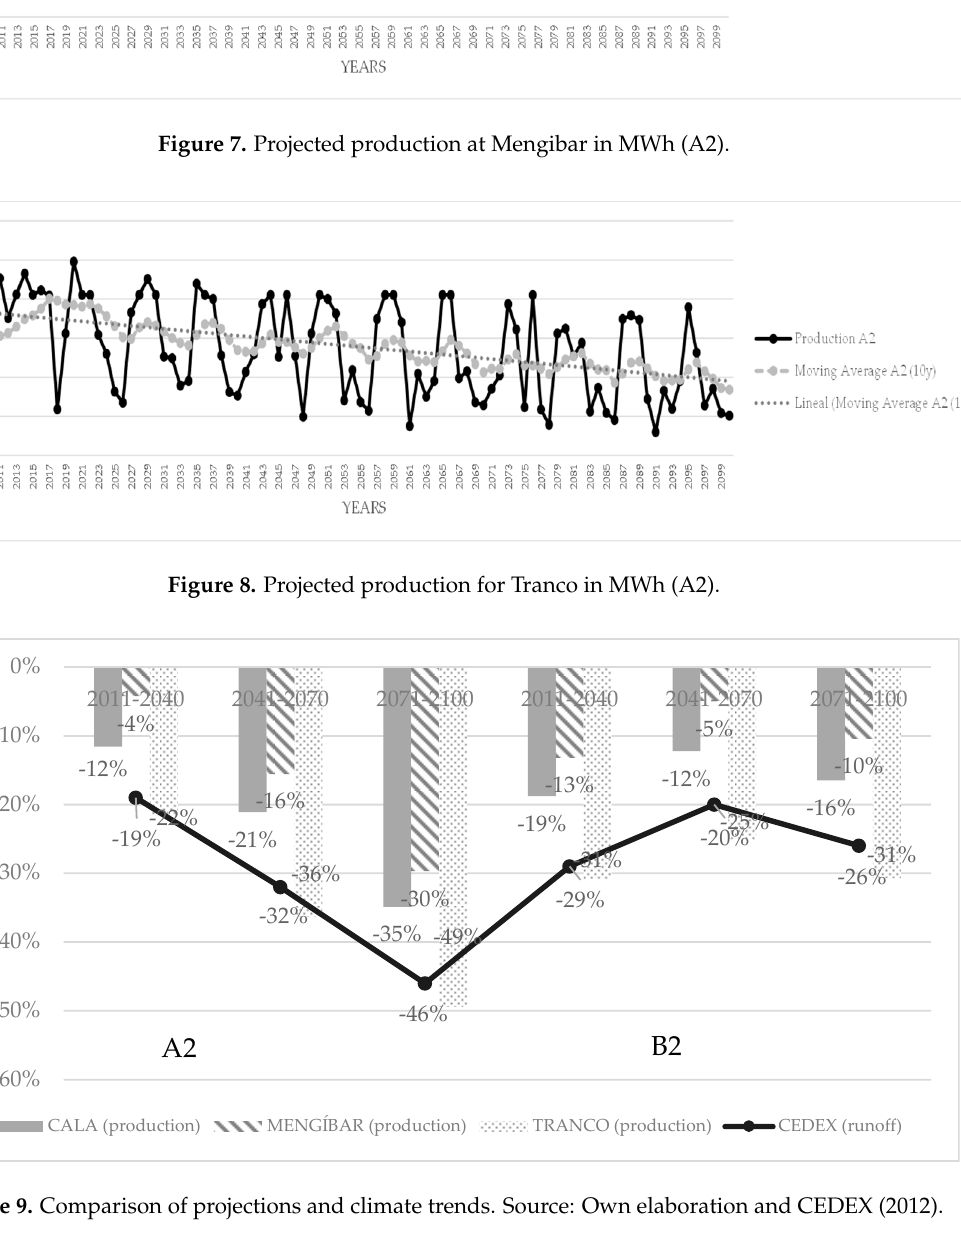
Figure 9. Comparison of projections and climate trends. Source: Own elaboration and CEDEX (2012). As shown above, the decrease in production is higher in plants with greater storage capacity.